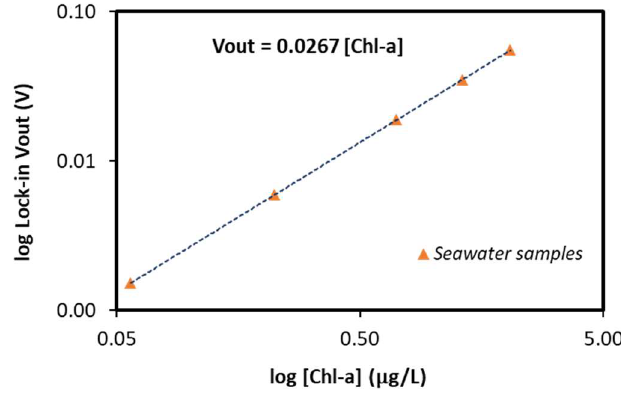
Figure 14. Measurement of five diluted seawater samples, with chlorophyll a concentration in the range 0.05–2 µg/L.